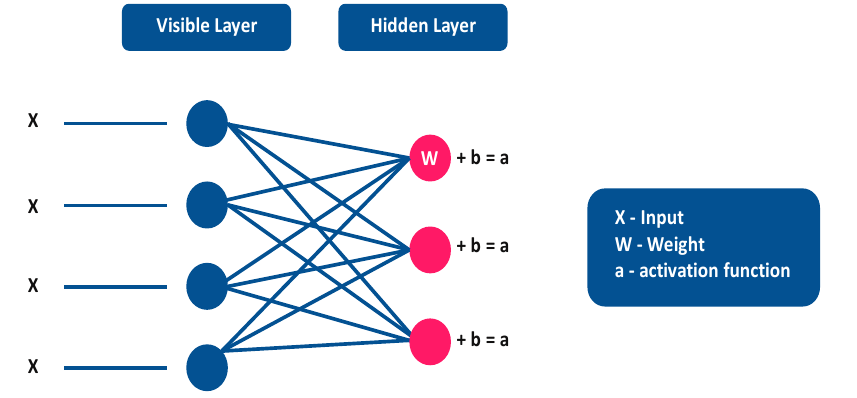
Figure 12. A representation of multiple inputs in an RBM